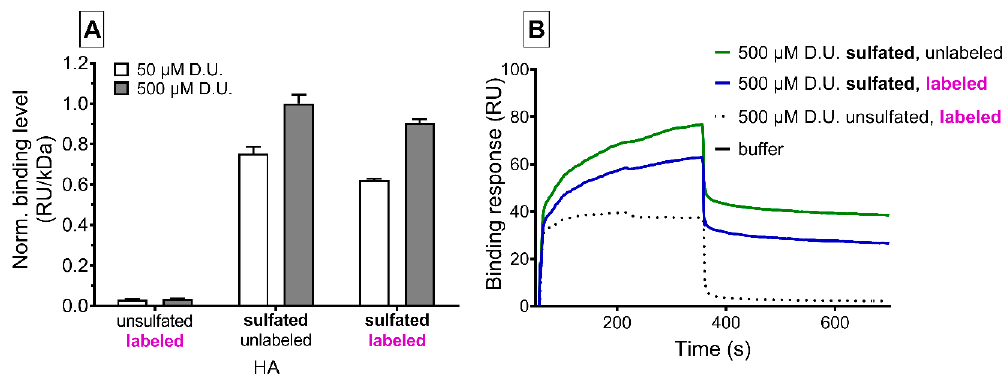
Figure 3. Surface plasmon resonance analysis of sclerostin/GAG interaction, reported as resonance units (RU). ( A ) Relative binding levels of labeled and unlabeled sulfated or native hyaluronan and corresponding sensorgrams ( B ). GAGs were injected at 50 and 500 µM related to the molecular weight of their disaccharide units (D.U.).